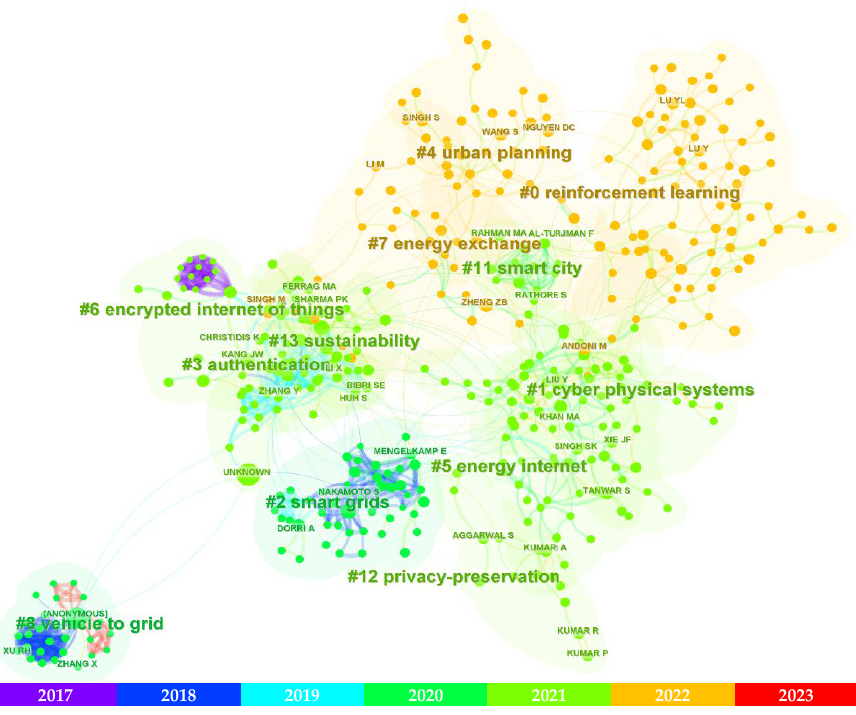
Figure 12. Largest author co-citation clusters in the subject field.